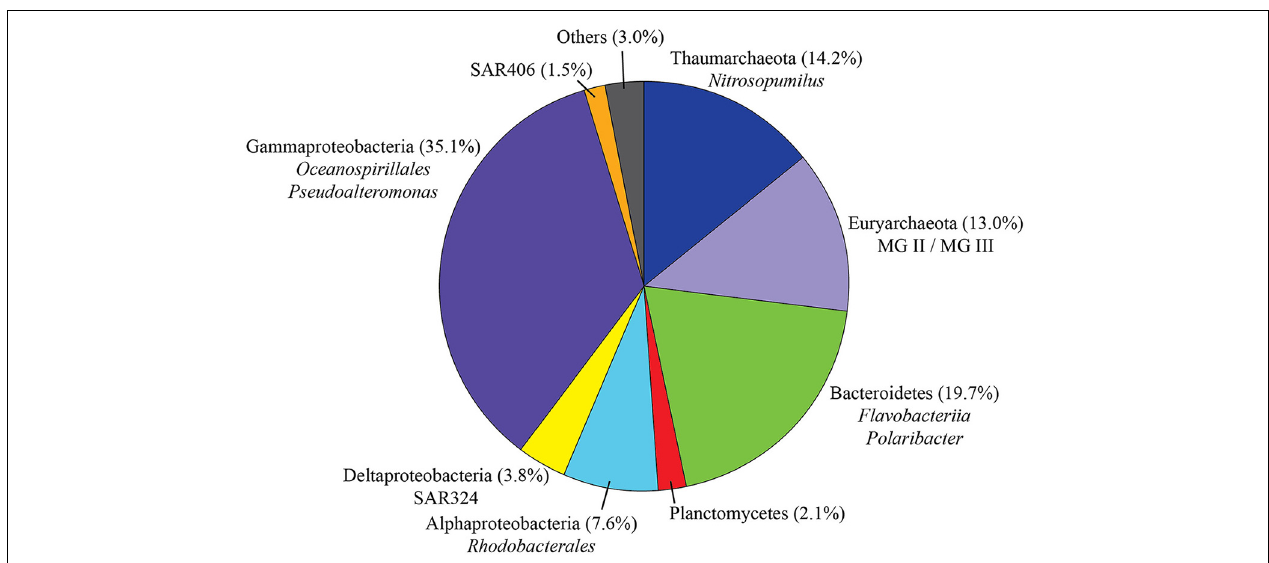
FIGURE 3 | Taxonomic distribution of all sequences retrieved during this study ( n = 146 , 287). “Others” comprises taxa accounting for less than 1% of the